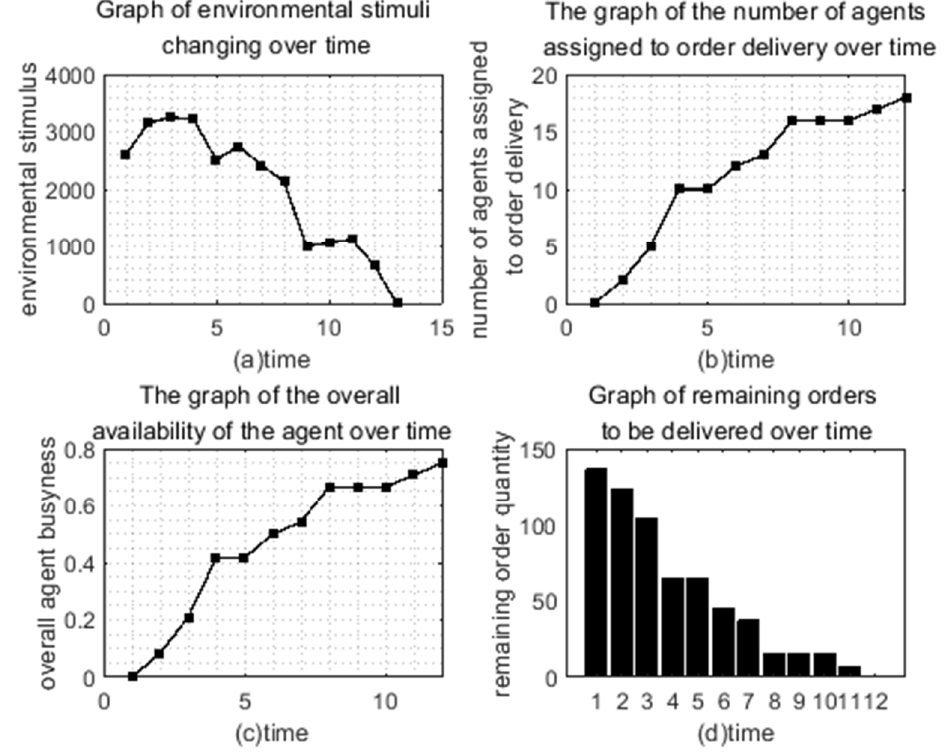
Figure 4. Order distribution macro picture.